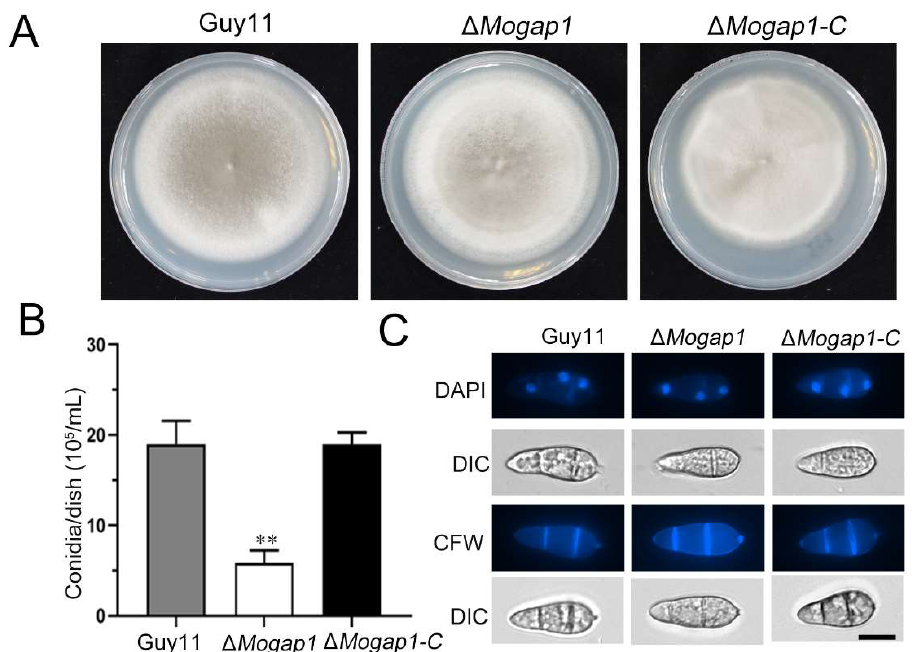
Figure 2. Colony morphology and sporulation of M. oryzae . ( A ) Colony morphology of Guy11, ∆ Mogap1 , and ∆ Mogap1-C after 9 days of culture. ( B ) The conidia of Guy11, ∆ Mogap1 , and ∆ Mogap1- C stained using DAPI and CFW on a scale of 10 µ m. ( C ) Relative spore formation of Guy11, ∆ Mogap1 , and ∆ Mogap1-C after 9 days of culture, the first of which differed significantly from the others. ** p < 0.01.